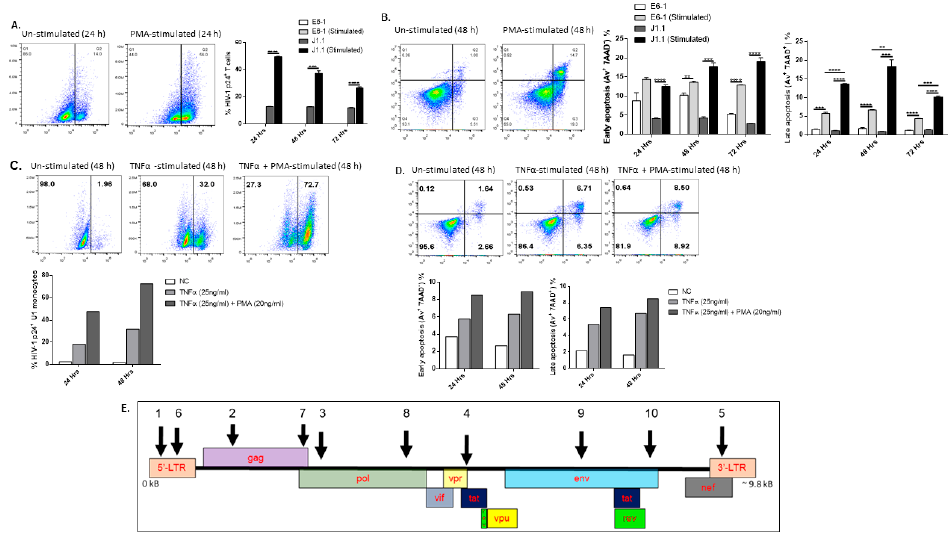
Figure 1. HIV reactivation induces cellular apoptosis in J1.1 T cells and U1 monocytes. ( A ) HIV latently infected Jurkat J1.1 and parental E6-1 cells were stimulated with 20 ng/mL PMA for 2 h, washed, and cultured for an additional 24–72 h to measure p24 expression. Representative dot plots and summary data from three independent experiments showing the percentage (%) of HIV p24 levels in E6-1 and J1.1 cells with or without PMA stimulation are shown. ( B ) Representative dot plots and summary data from three independent experiments showing the percentage (%) of early (Av + 7AAD − ) and late (Av + 7AAD + ) apoptotic E6-1 and J1.1 cells with or without PMA stimulation for 48 h. ** p < 0.01, *** p < 0.001, **** p < 0.0001. ( C ) Representative dot plots and summary data showing the percentage (%) of HIV p24 levels in U1 monocytes with or without TNF α and PMA stimulation for 24–48 h. ( D ) Representative dot plots and summary data showing the percentage (%) of early (Av + 7AAD − ) and late (Av + 7AAD + ) apoptotic U1 monocytes with or without TNF α and PMA stimulation for 24–48 h. ( E ) Specific gRNAs (numbered according to the order of their synthesis) targeting different sites within the HIV-1 genome (indicated by arrows) were generated using the E-CRISP online tool.